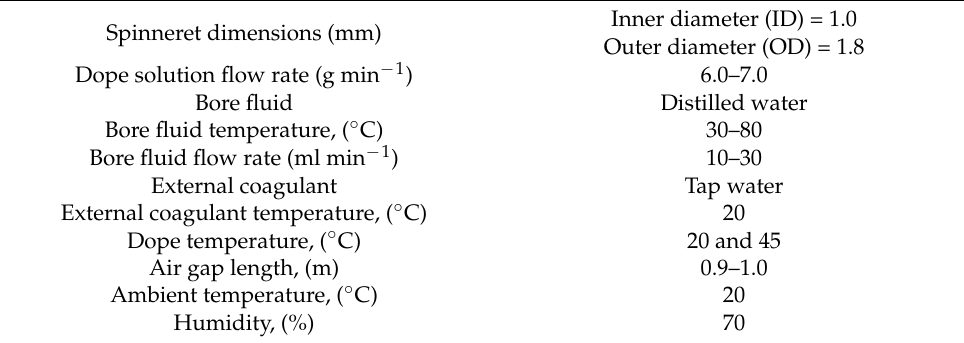
Table 1. Spinning conditions for PSF hollow fiber membrane formation by free fall spinning technique.